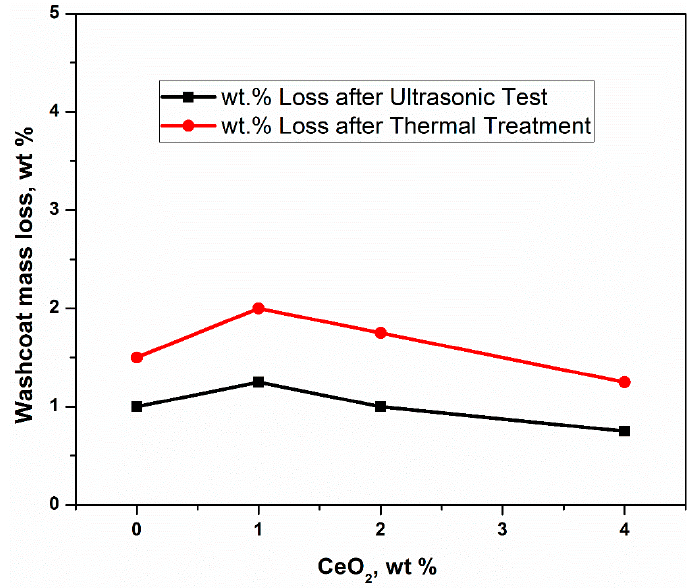
Figure 1. Effect of CeO 2 loading on the adhesion properties and thermal stability of the washcoat. Figure 1. E ff ect of CeO 2 loading on the adhesion properties and thermal stability of the